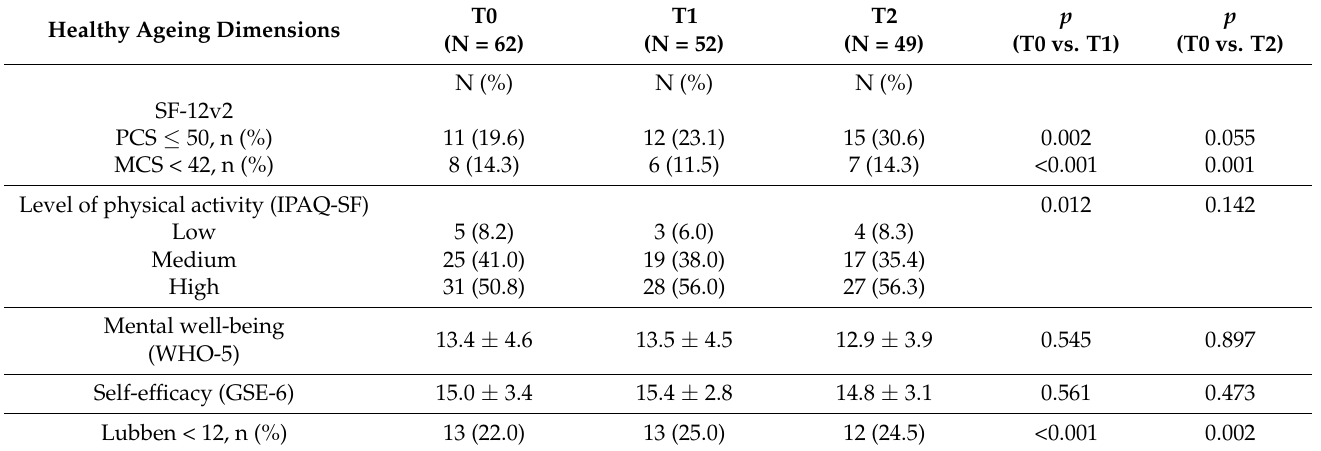
Table 3. Impact of the AgeWell digital coach on the healthy ageing dimensions over